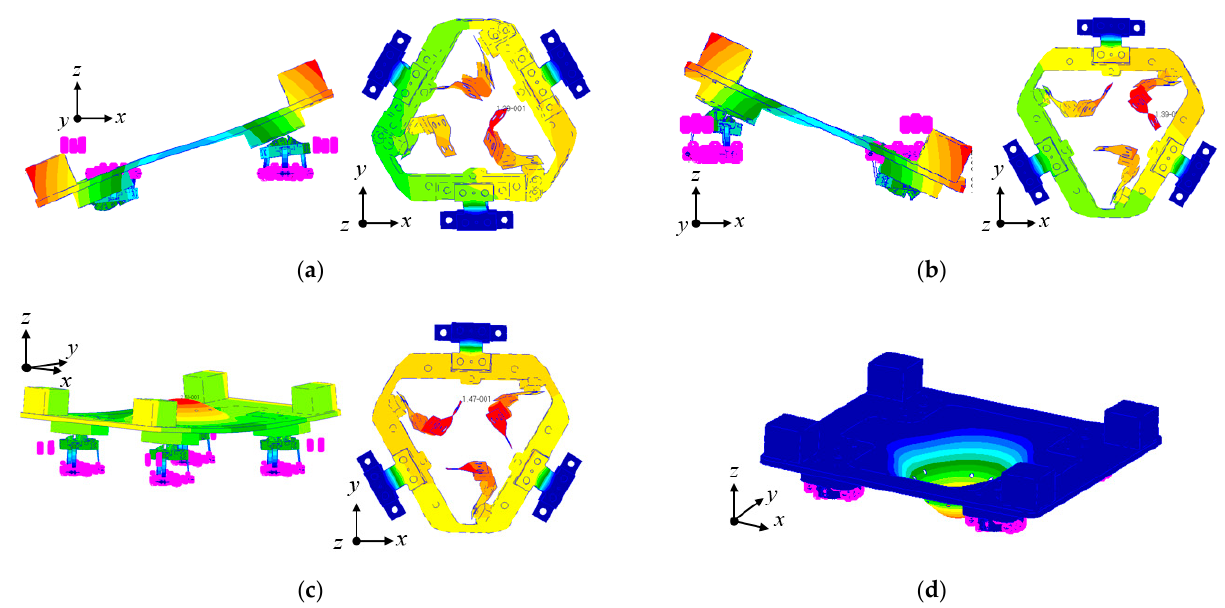
Figure 5. Modal Analysis Results (( a ) 1st Mode, ( b ) 2nd Mode, ( c ) 3rd Mode, and ( d ) 4th Mode).